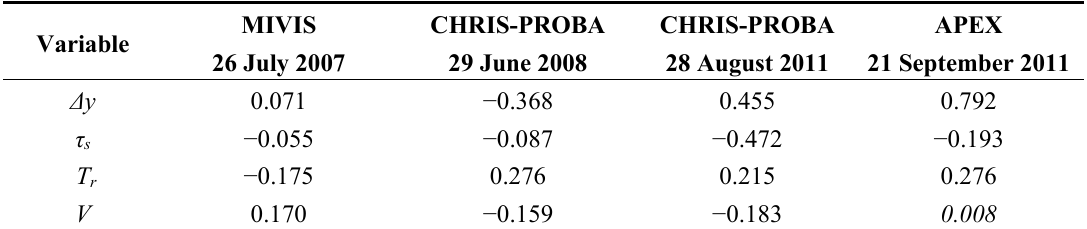
Table 5. Correlation coefficients between the remote sensed Chl- a distributions and the simulated hydrodynamic variables for the simulated images conditions (correlations with p >0.001 are typed in